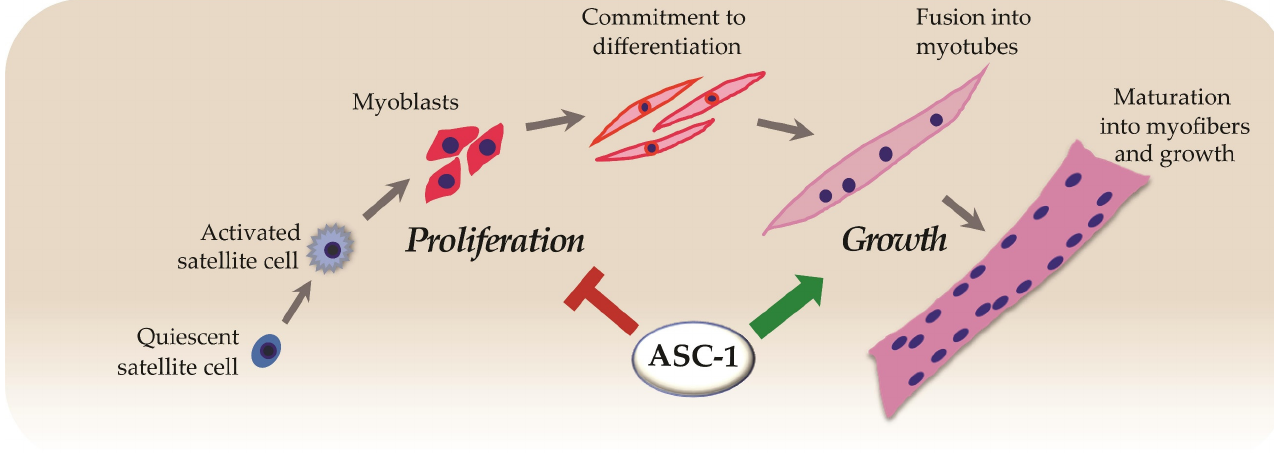
Figure 4. ASC-1 modulates cell cycle progression in proliferative myogenic cells by regulating cell cycle protein expression and phosphorylation [22] and promotes muscle cell growth [18].